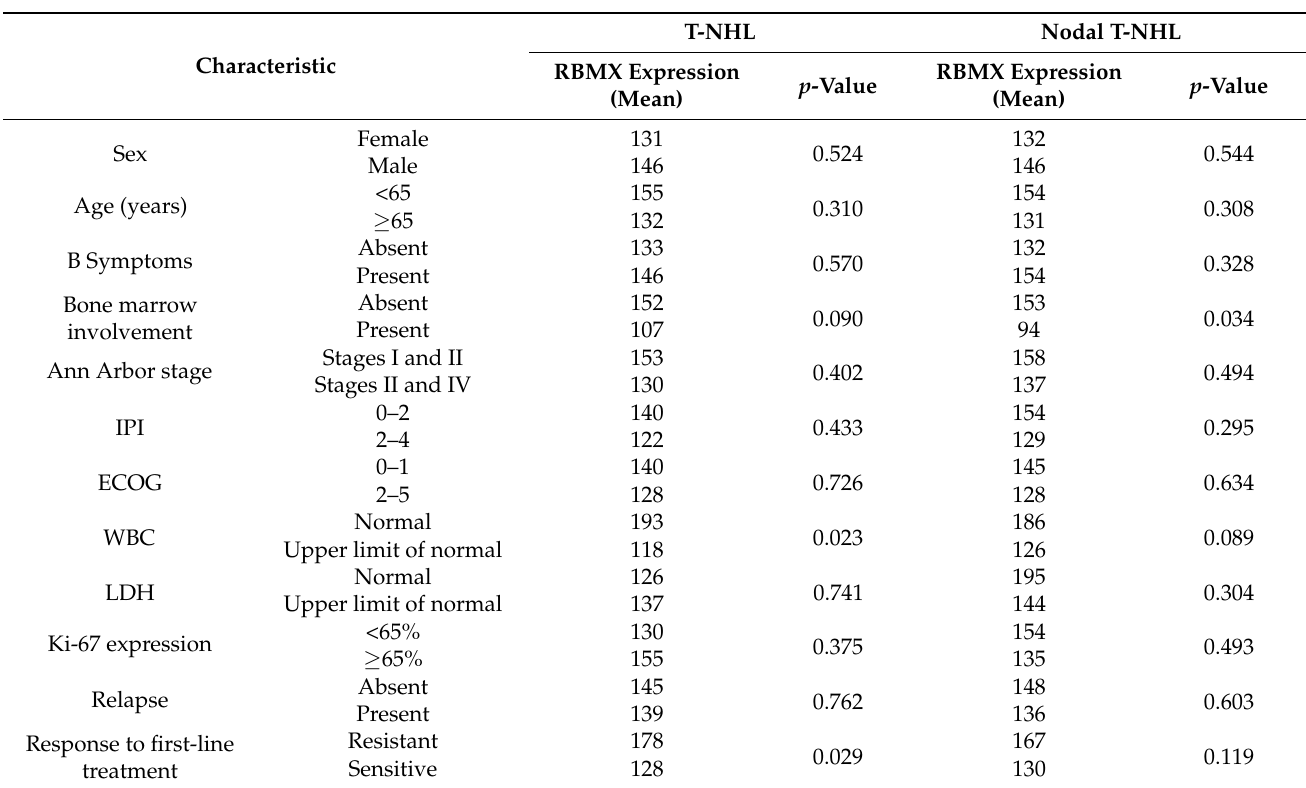
Table 2. Correlations between RBMX expression (H-score) and the clinicopathological characteristics in T-NHL and nodal T-NHL.